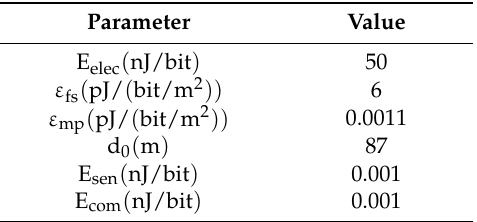
Table 1. Simulation parameters for the networks.